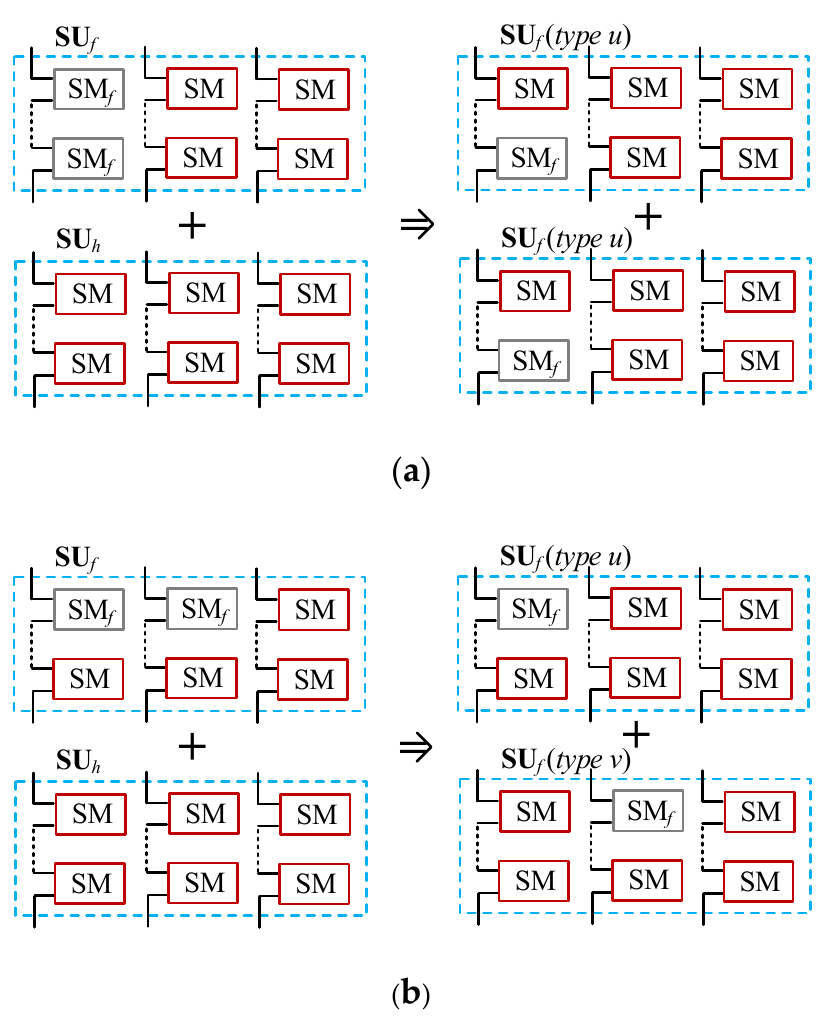
Figure 6. Decomposition of multiple SM faults in ( a ) one defected phase ( b ) two defected phases.